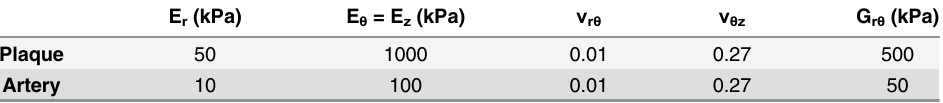
Table 1. Material Properties of the Plaque and Artery Used in the Structural